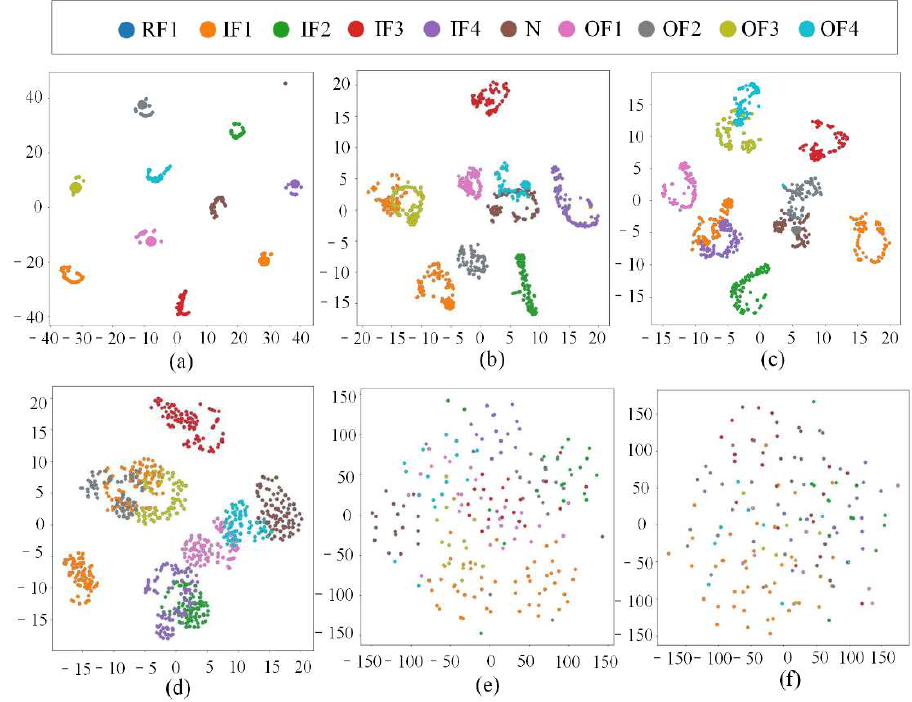
Figure 23. Visualization of different diagnostic results on dataset B, ( a ) The proposed method, ( b ) GAF-SE-CNN, ( c ) GAF-CBAM-CNN, ( d ) GAF-BAM-CNN, ( e ) VMD-Gray image-Resnet50, ( f ) EMD-Gray image-Resnet50.